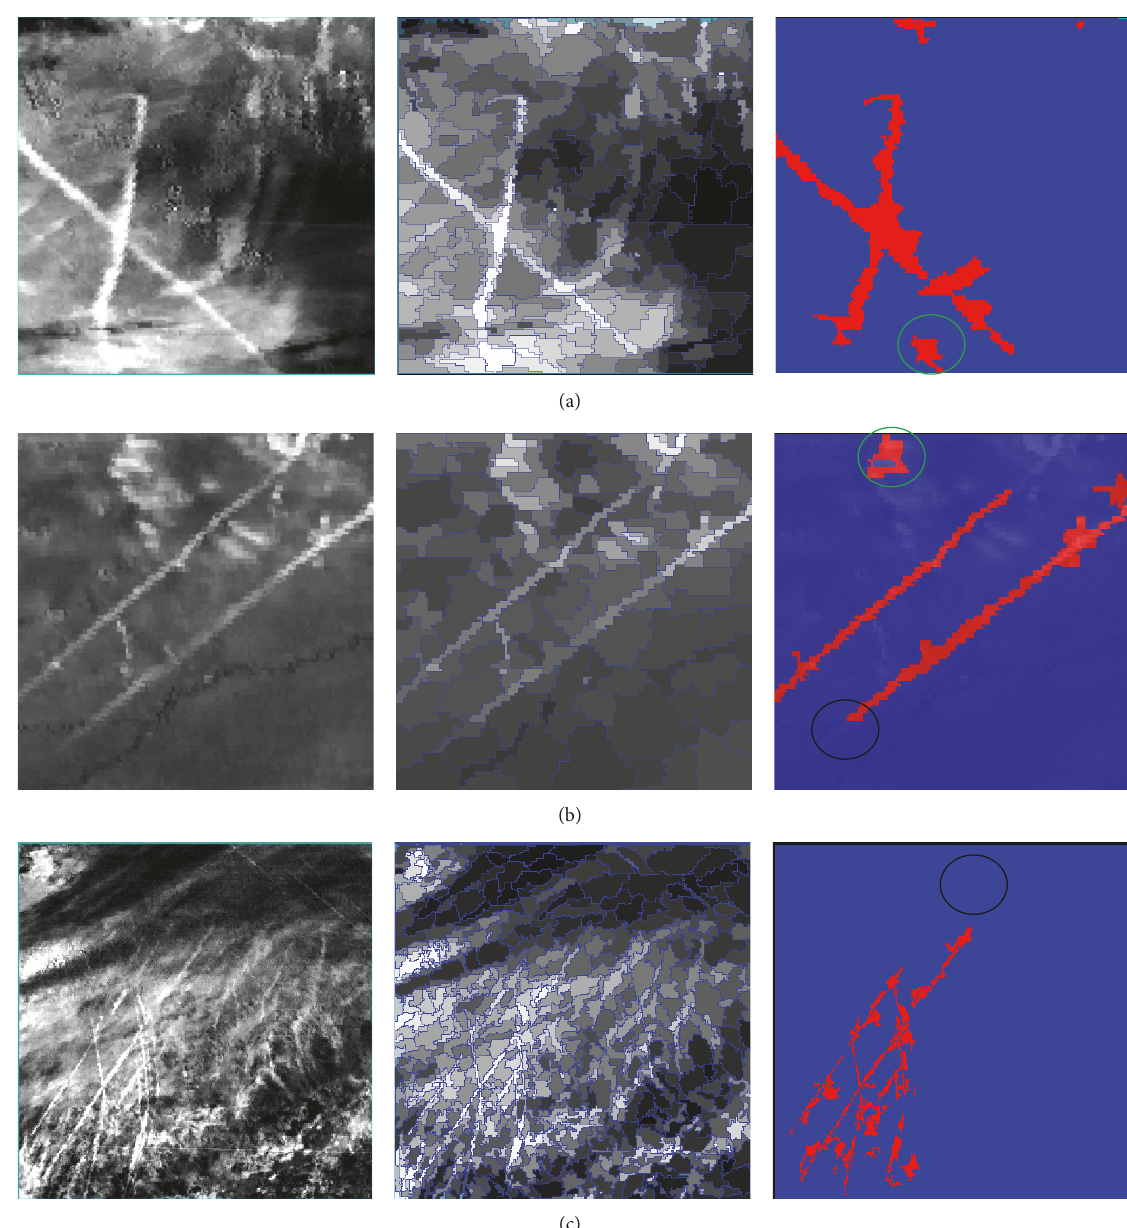
Figure 5: The results of the object-based segmentation and classification under the three different scenarios: (a, b, c: left) is the original BTD image; (a, b, c: middle) is the result of segmentation; (a, b, c: right) is the final contrail classification result (green cycle: false alarms and black cycle: